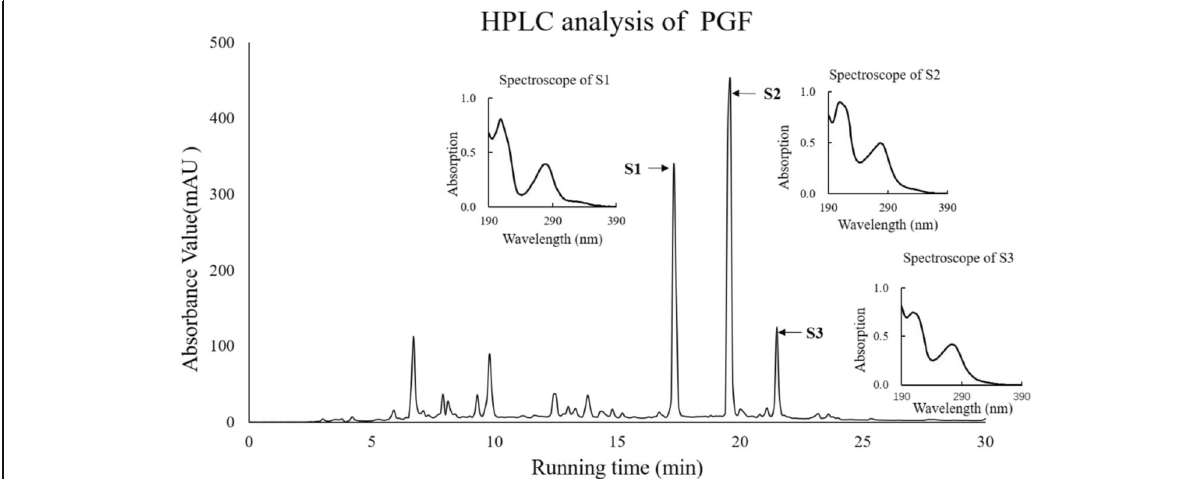
Fig. 1 HPLC analysis of the PGF from PCP. First, 10 μ L of the PGF (10 mg/mL) was analysed with a C18 reversed-phase column (Dionex). The process was monitored by a 254 nm UV detector. The Rt values of S1, S2 and S3 were 17.94, 20.22 and 22.13 min,